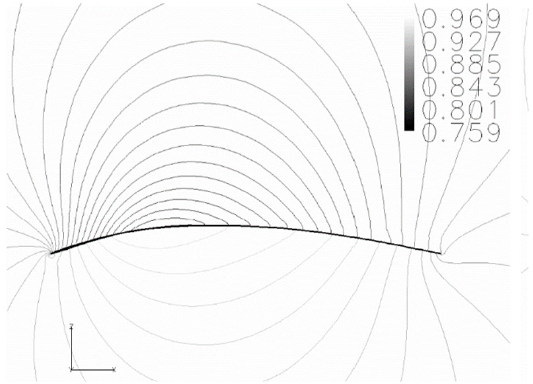
Figure 14. Optimized airfoil for Martian aircraft with pressure contour lines indicated [37].